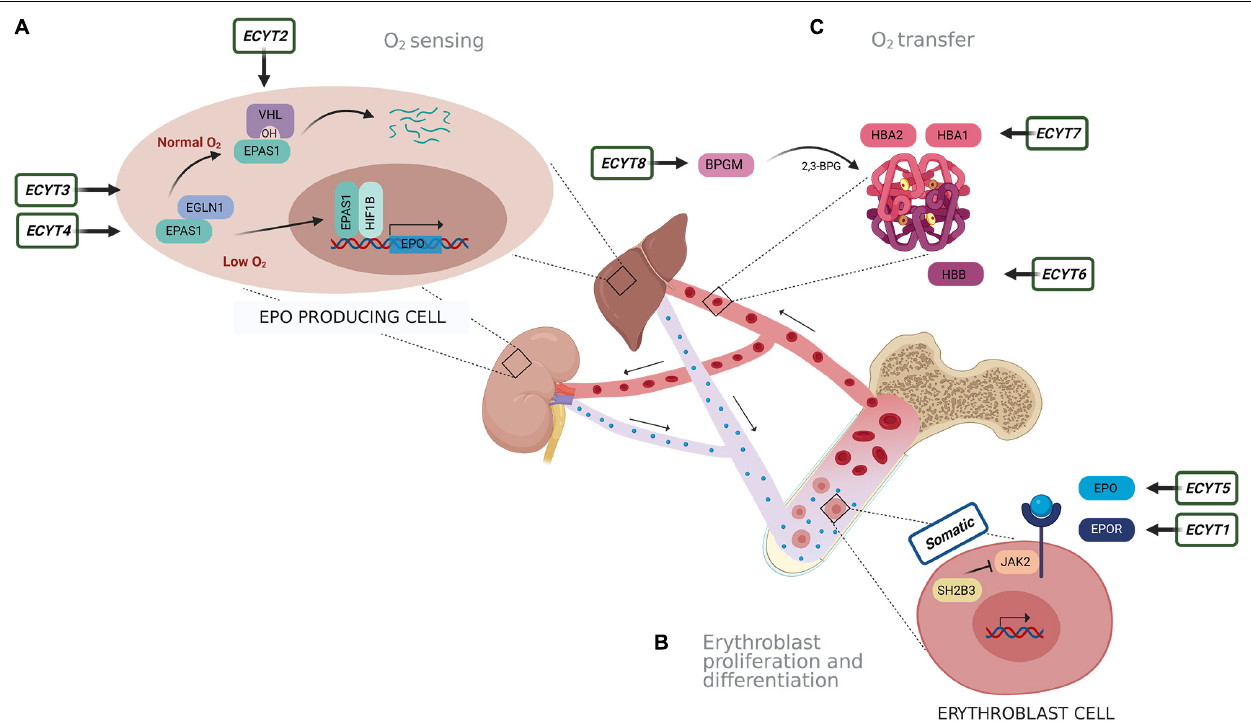
FIGURE 1 | Schematic presentation of genes responsible for eight types of congenital erythrocytosis (ECYT1–8) and somatic erythrocytosis. Genes are involved in pathways of (A) oxygen sensing, (B) signaling for proliferation and differentiation of erythroblasts and (C) oxygen transfer. (A) Oxygen is detected in the liver and kidney. In the normal oxygen conditions, hypoxia-inducible transcription factor (HIF) (the main isoform associated with the erythropoiesis is EPAS1) is hydroxylated by prolyl hydroxylase EGLN1, following binding of VHL . This results in ubiquitination and degradation of HIF. Under hypoxic conditions (e.g., 1% O 2 ), oxygen availability is limited; thus, hydroxylation is diminished. This results in the stabilization of HIF that is transported to the nucleus where it forms a dimer complex with its beta subunit HIF1B (officially termed ARNT) and acts as transcription factor on numerous target genes, including EPO . (B) EPO is transported to the bone marrow, where it binds with its receptor EPOR on the erythroblast cells. This subsequently activates JAK2 signaling cascade for proliferation and differentiation of erythroblasts. SH2B3 is an inhibitor of JAK2 kinase. (C) Hemoglobin alpha (HBA1 and HBA2) and beta (HBB) are important binding proteins for oxygen and are involved in oxygen transfer. The enzyme BPGM forms an allosteric effector 2,3-biphosphoglycerate (2,3-BPG) for regulation of hemoglobin oxygen